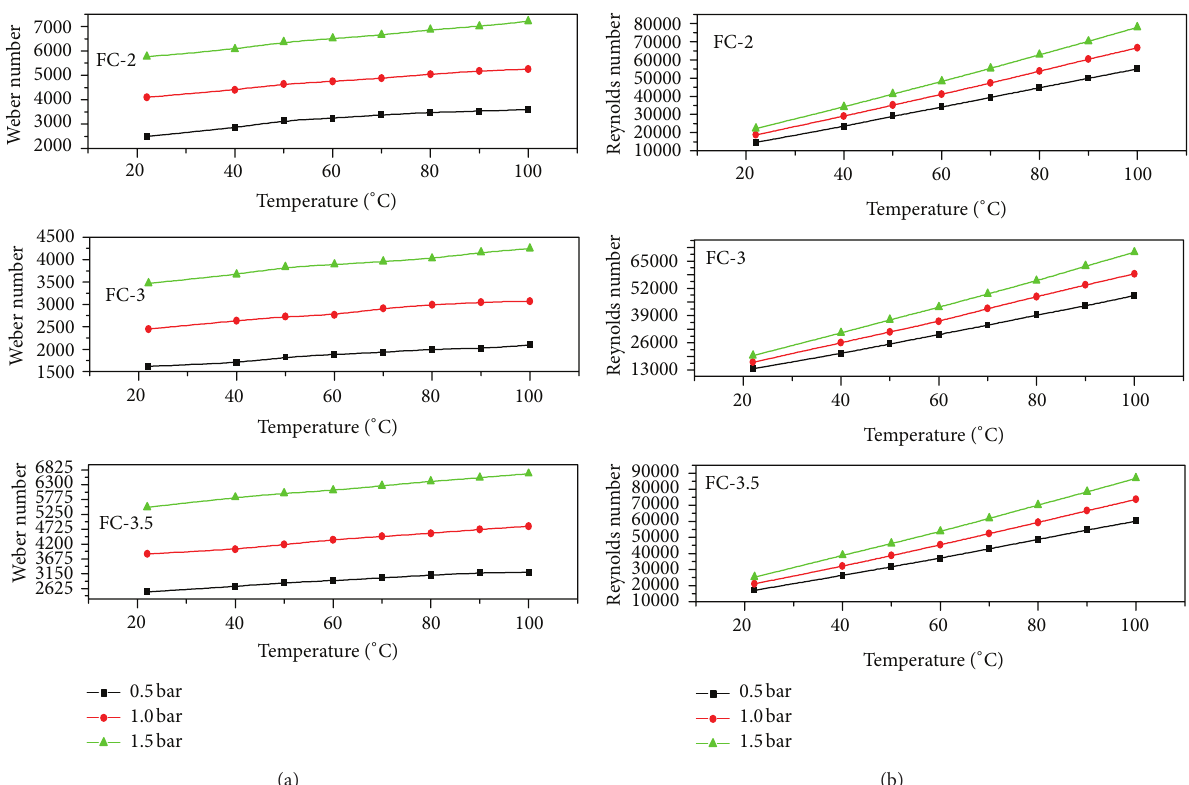
Figure 4: (a) Weber number as a function of temperature, (b) Reynolds number as a function of